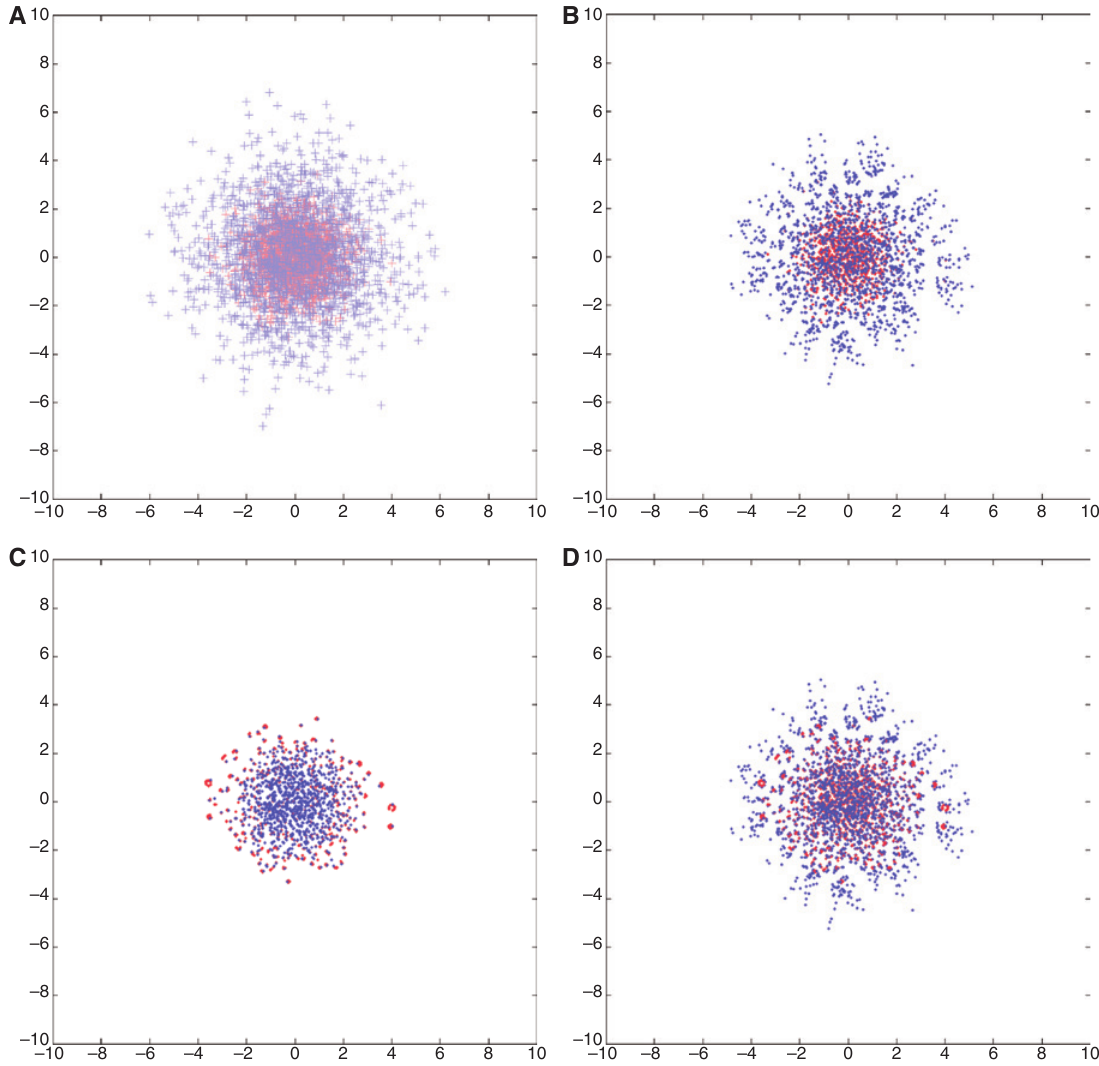
Figure 6: (A) “Gaussian 2D” Highly Overlapping Two-Class Synthetic Data Set having 3750 Samples. (B) FMCOVs. (C) AMCOVs. (D) Both FMCOVs and AMCOVs. [9].